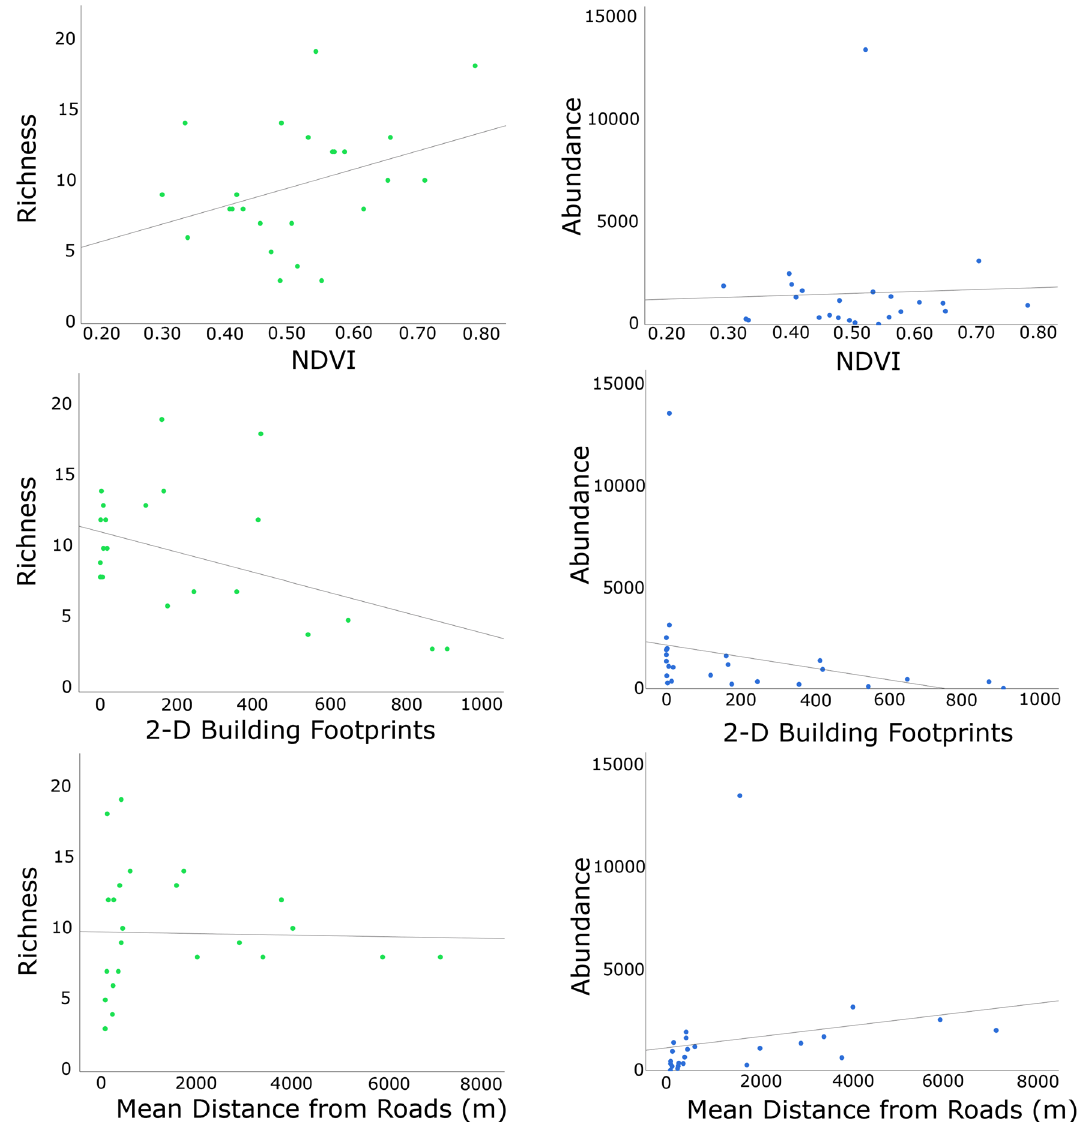
abundance relationship with NDVI, building footprint, and mean distance from roads (in